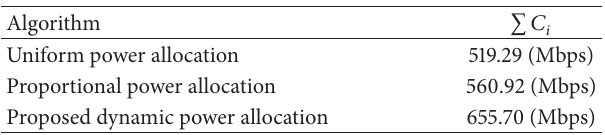
Table 5: Total system capacity for the three algorithms in Scenario 3.